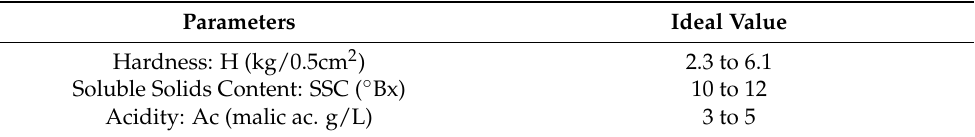
Table 2. Ideal values range of physical and chemical parameters of perceived quality of peaches.